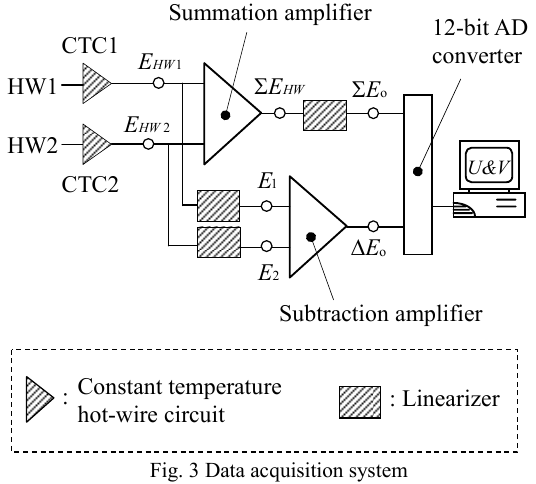
Fig. 3 Data acquisition system